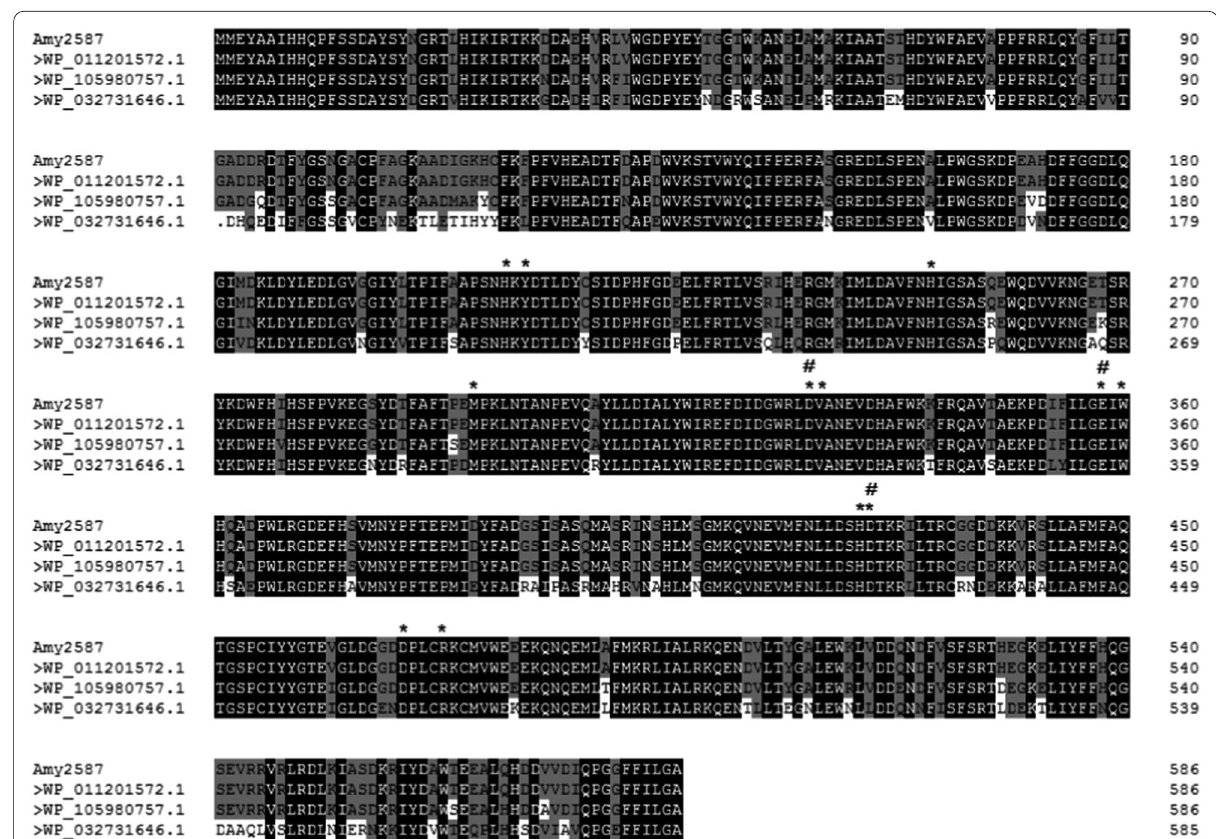
Fig. 2 Multiple sequence comparison of the α-amylase